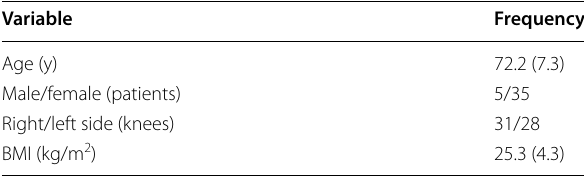
Table 1 Patients’ background